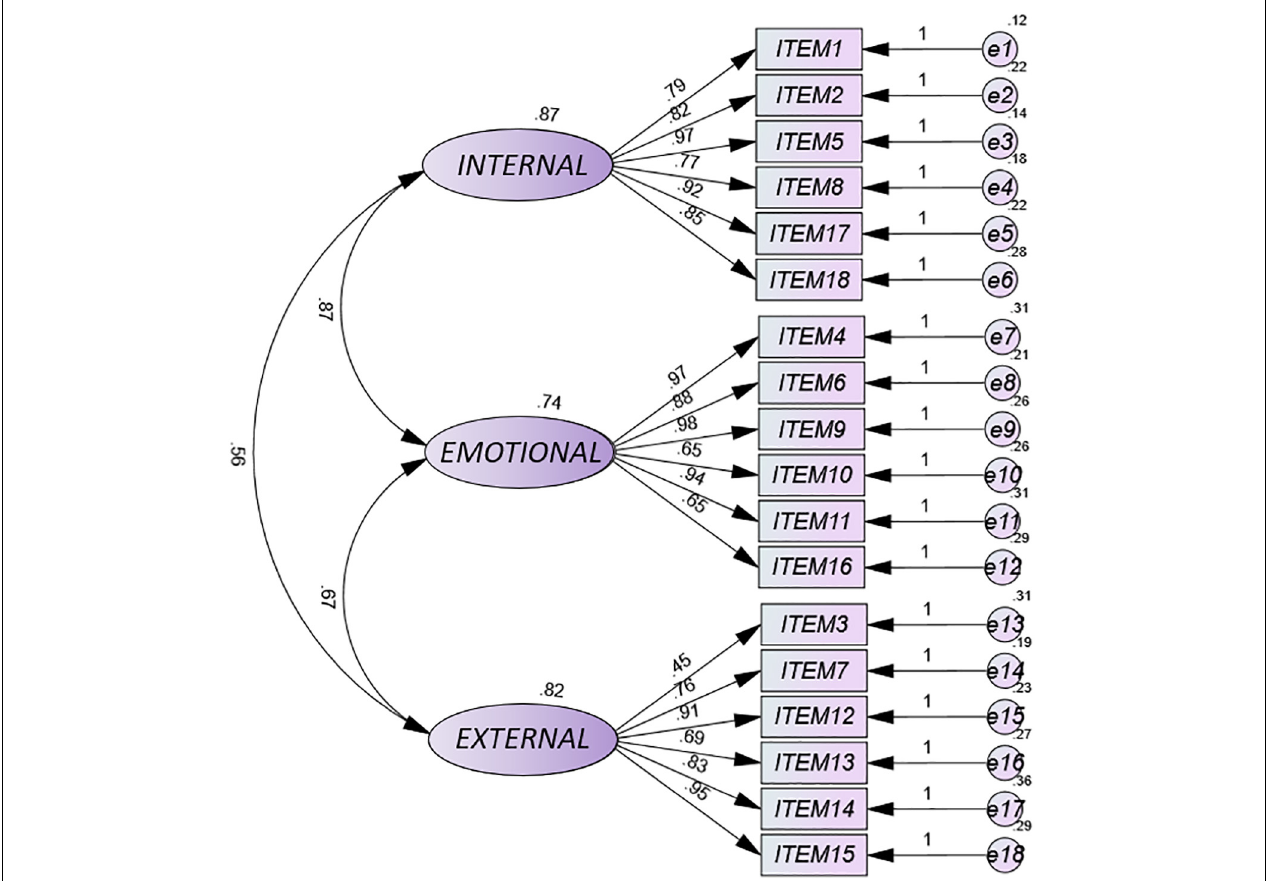
FIGURE 1 | Path diagram of